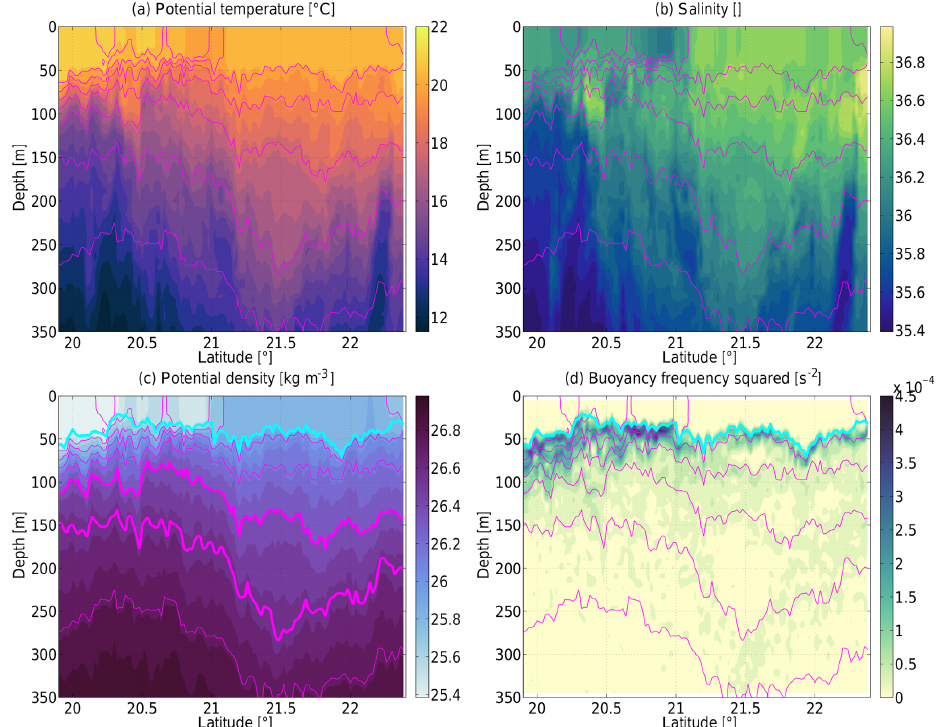
Figure 4. Sections of (a) potential temperature (in degrees Celsius), (b) salinity, (c) potential density (in kilograms per cubic meter), and (d) stratification (buoyancy frequency squared) (in per second squared). In this and all the following figures, the magenta lines are isopycnals plotted at a spacing of 0.2kgm − 3 ; the 26.4 and 26.6kgm − 3 isopycnals are plotted as thick lines in (c) . The cyan line here and below indicates the base of the mixed layer as determined from a density difference with respect to the surface of 0.05kgm − 3 .